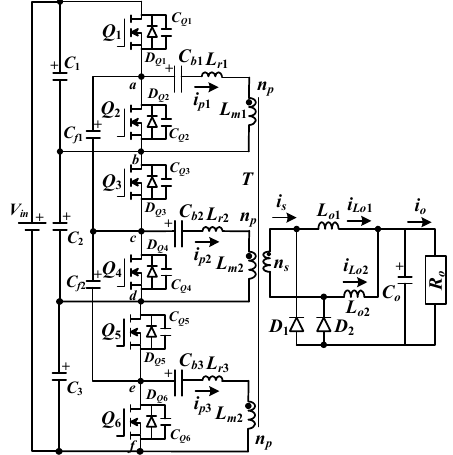
Figure 3. Circuit schematic of the studied converter.